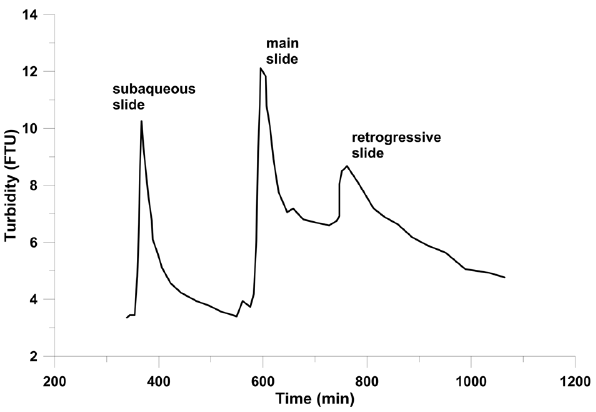
Figure 6. Measurement of turbidity at Lärjeholm 2.6 km downstream the site at the day of the slide. Adopted from Larsson et al. (1994). Fig. 6. Measurement of turbidity at L¨arjeholm, 2.6km downstream the site, at the day of the slide. Adopted from Larsson et al. (1994).